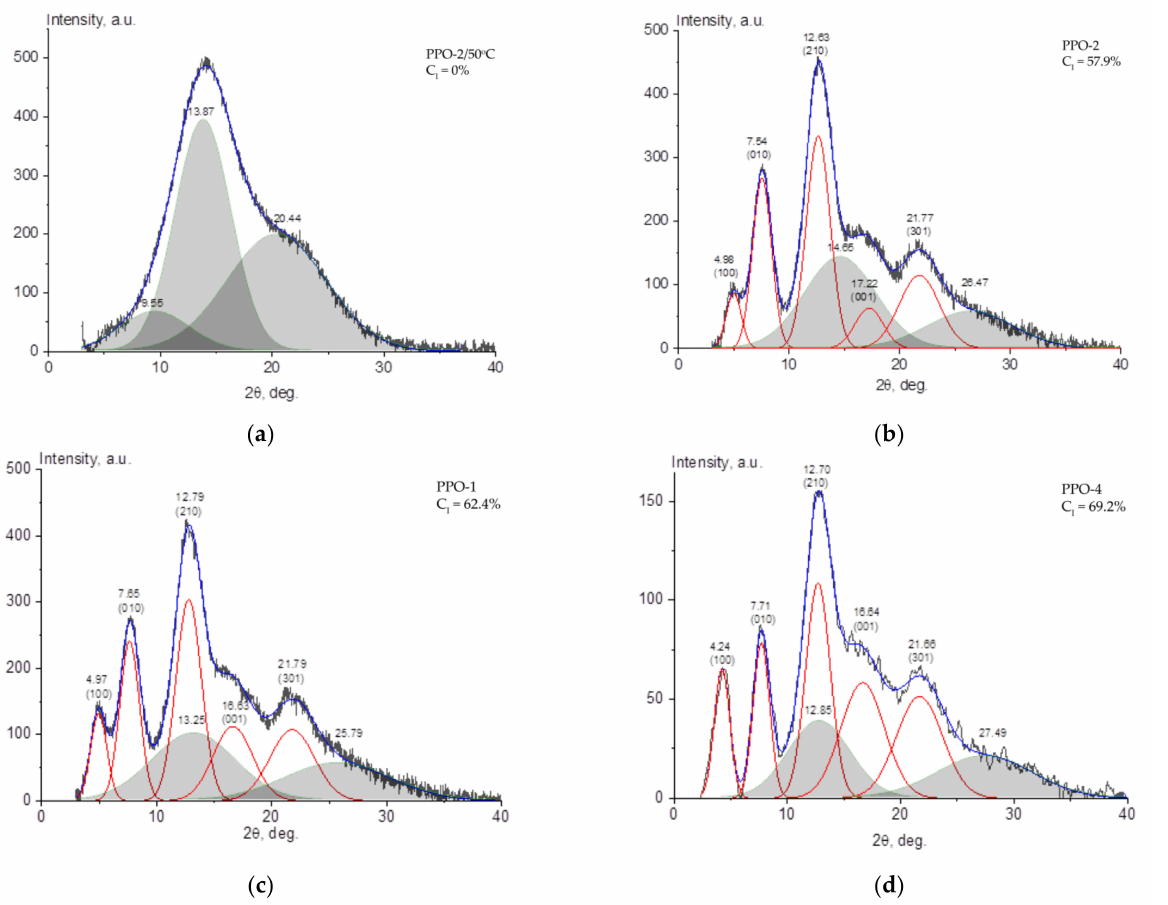
Figure 2. Diffractograms of PPO film samples with peak deconvolution. Grey peaks represent an amorphous phase. Red line peaks correspond to the peaks crystalline phase, blue line is a sum of the red peaks. Values over the peaks of crystalline phase are d-spacings and Miller indices (in parentheses). ( a ) PPO-2/50 ◦ C film (C I = 0%); ( b ) PPO-2 film (C I = 57.9%); ( c ) PPO-1 film (C I = 62.4%); and ( d ) PPO-4 film (C I =